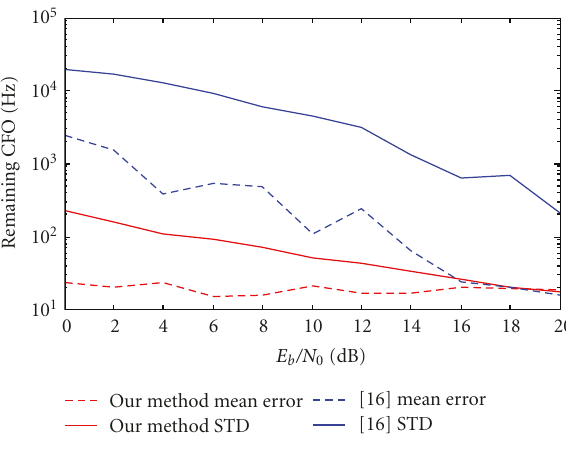
Figure 5: Remaining